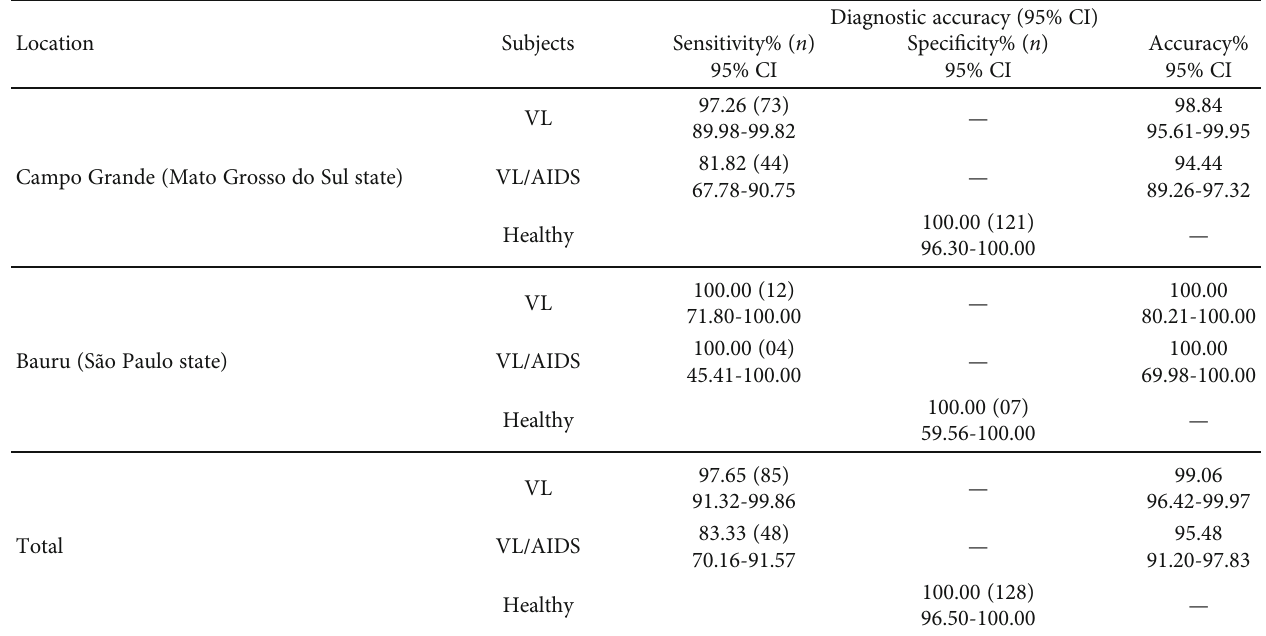
Table 4: Performance of DTL-4-ELISA to diagnosis of VL in samples of AIDS patients from di ff erent locations in Brazil. Location